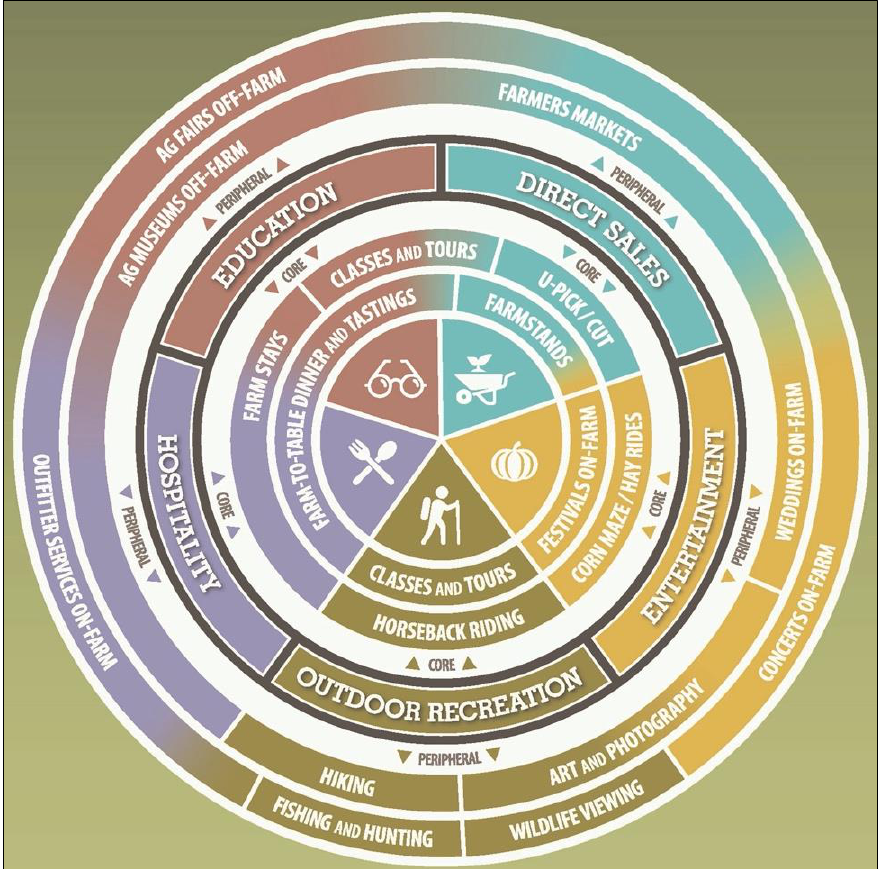
Adapted from Streifeneder (2016, p. 259). Figure 4. Conceptual Framework for Understanding Agritourism in the